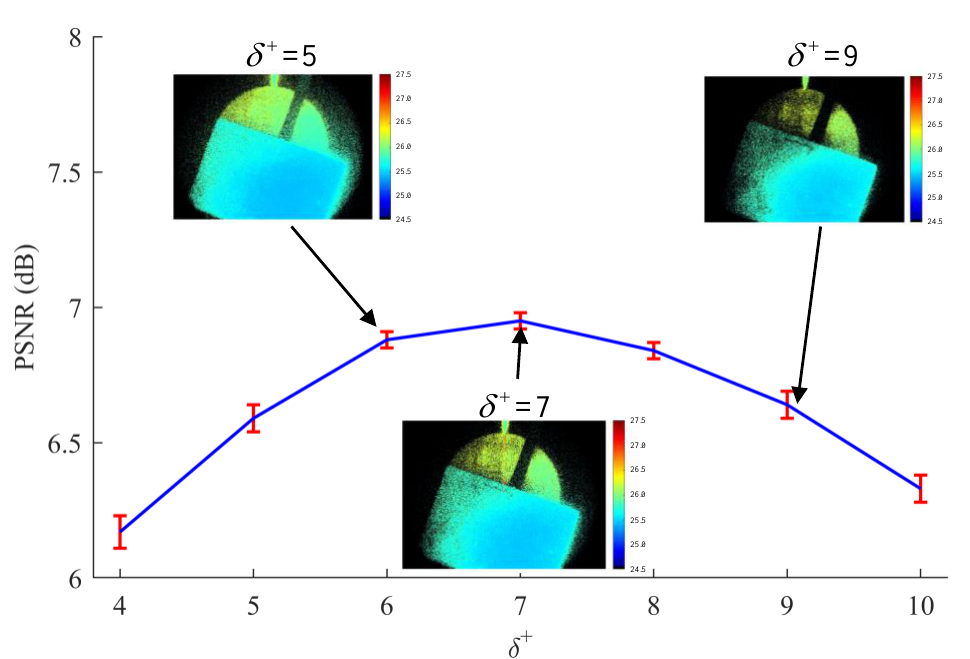
Figure 6. The averaged PSNR curve of the distance information obtained by the constant threshold AFD method with different constant thresholds in five